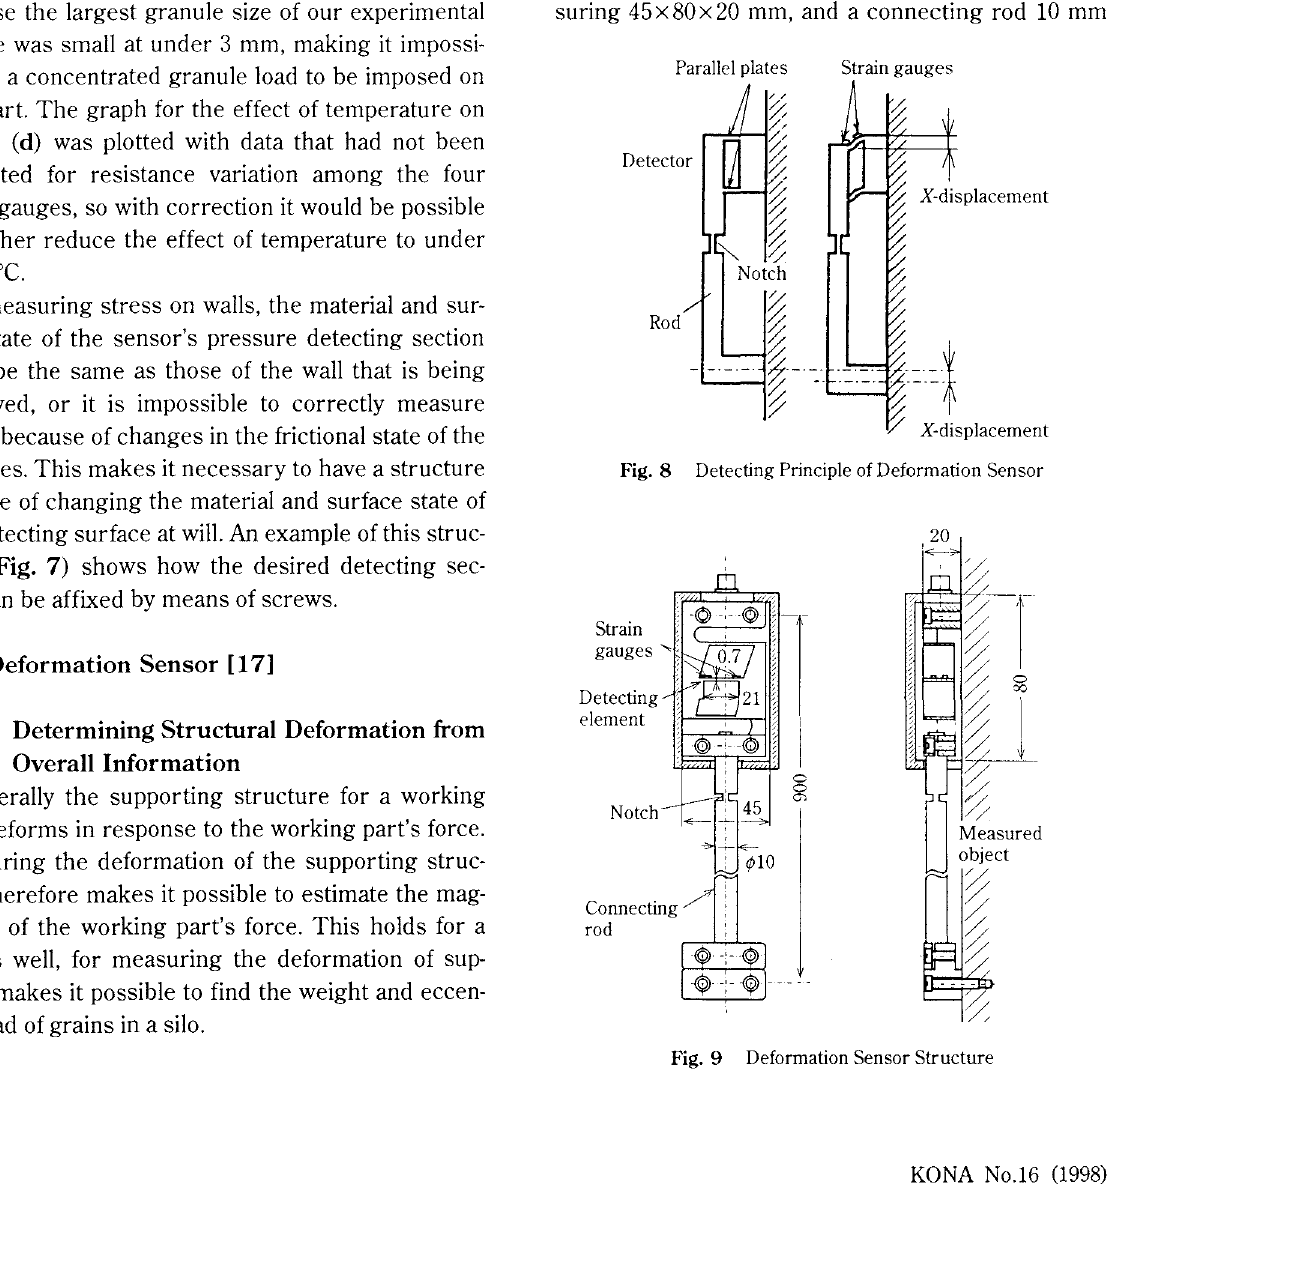
Fig. 7 Two-Directional Stress Cell Exchangeable Wall